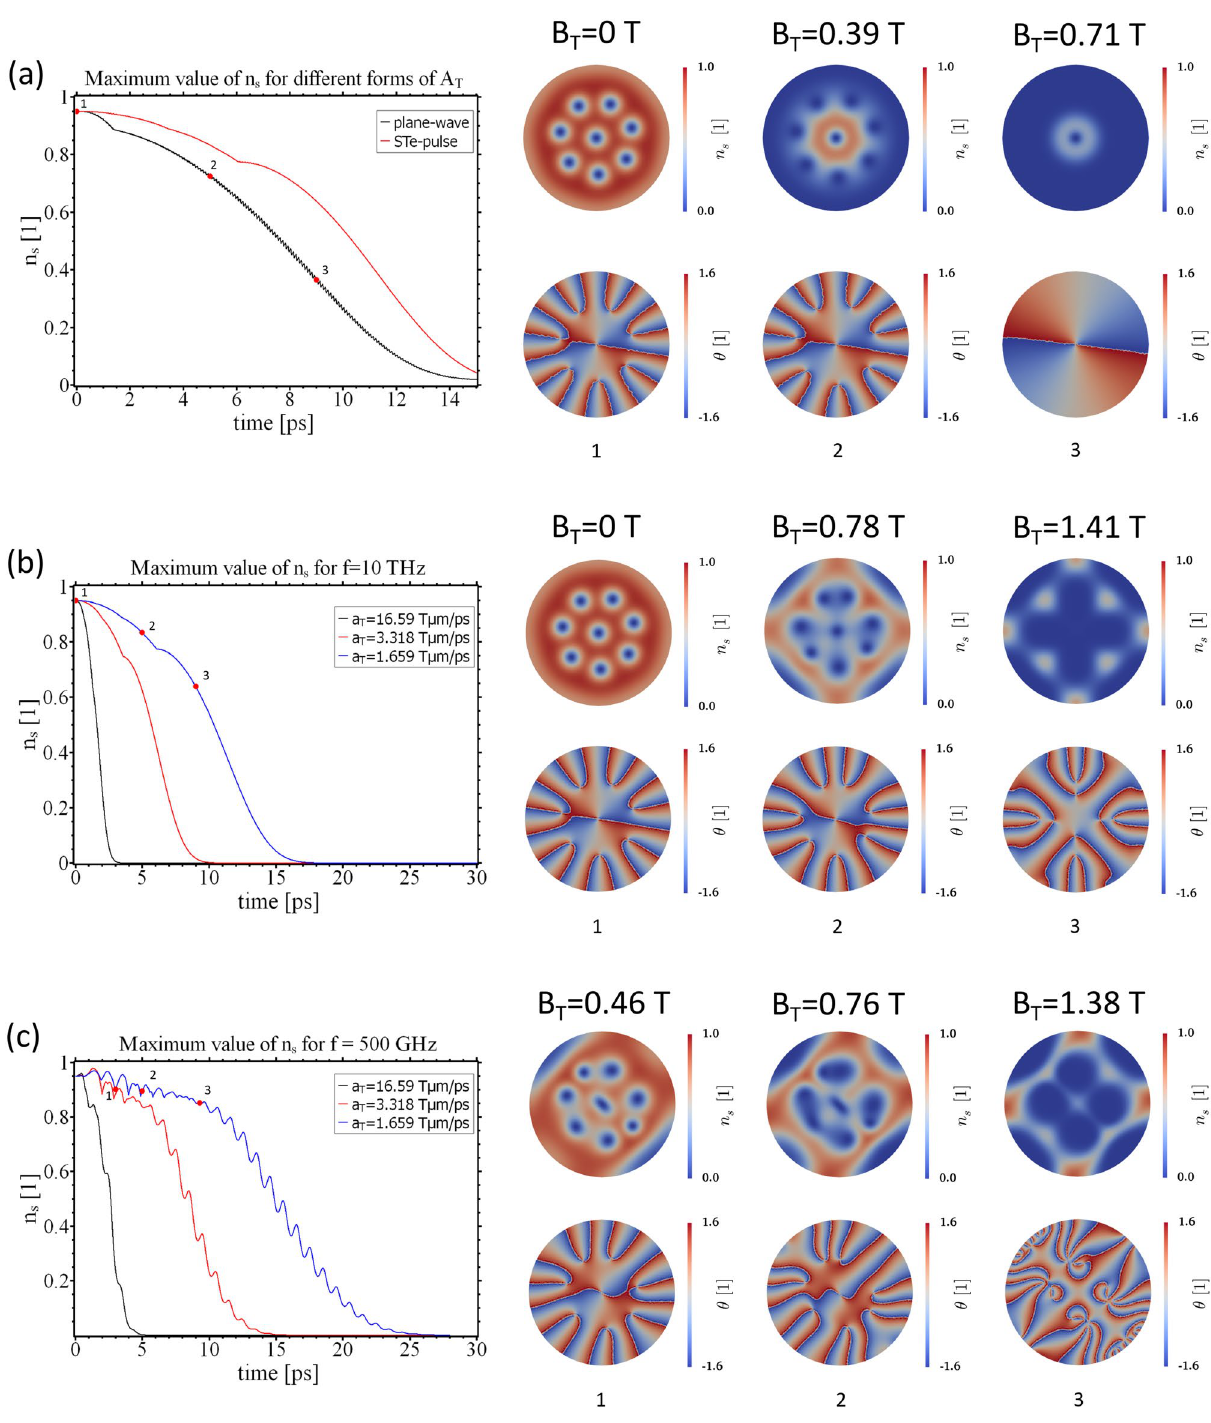
0.17 T and different THz field pulses. ( a ) vortex state under application = 0.41 Tμm/ps) and a STE-pulse (red curve and a T = 10 THz and f 500 GHz and different ramping rates a = =